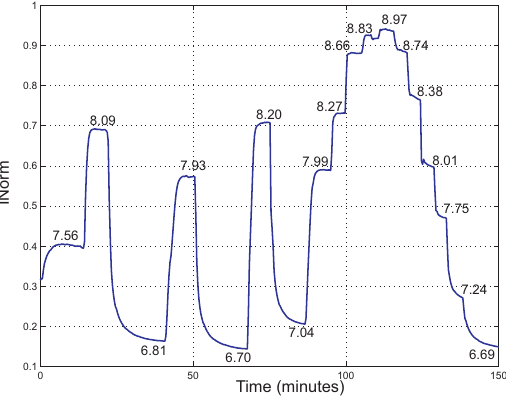
Figure 7. I versus time of a measurement performed in an aqueous solution, changing Norm the pH value of the solution. The steady state pH values of the solution as measured by the reference instrument are reported close to the curve.